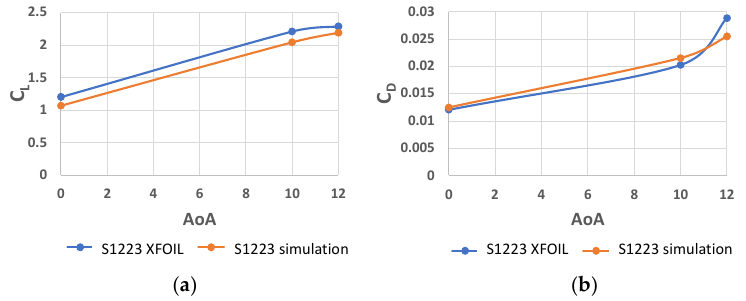
Figure 6. Comparison of XFOIL data with simulated results: ( a ) C L and ( b ) C D .